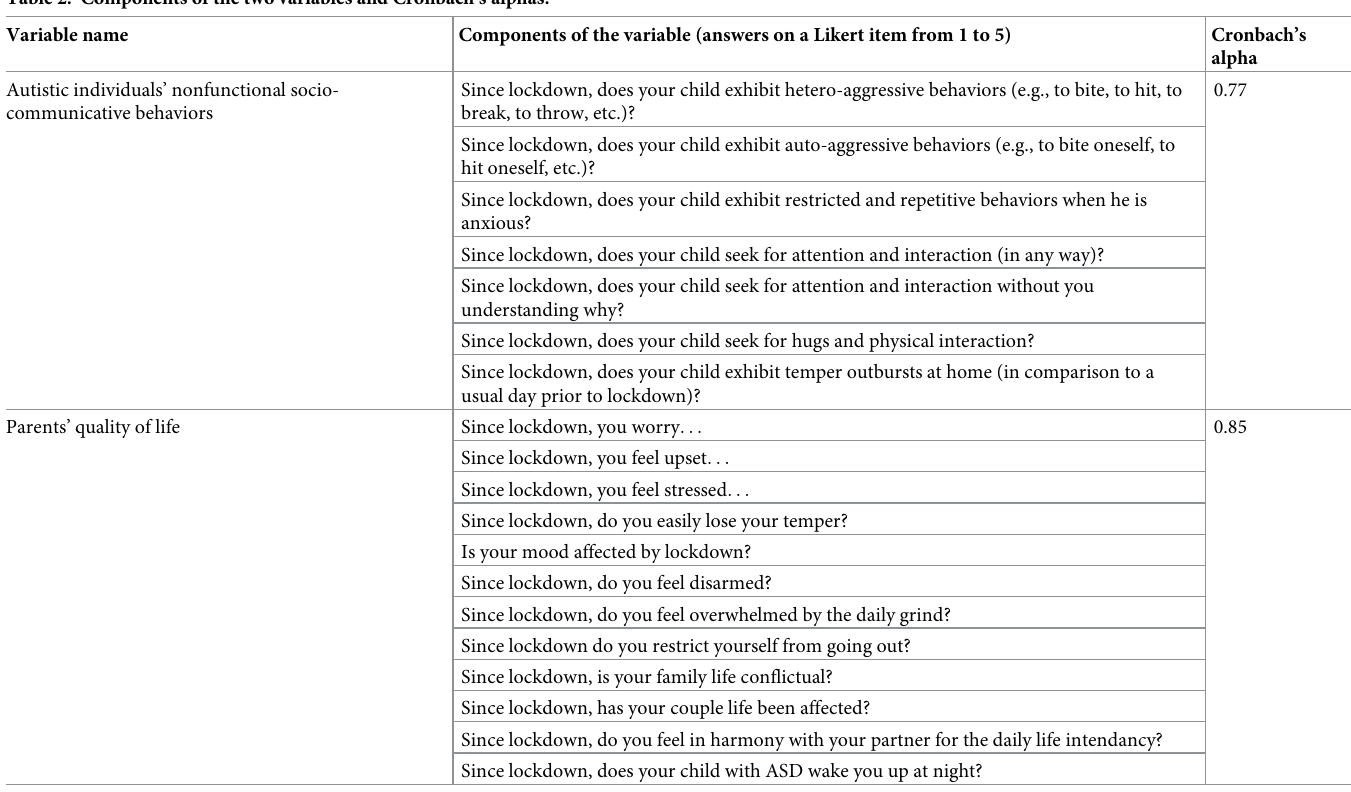
Table 2. Components of the two variables and Cronbach’s